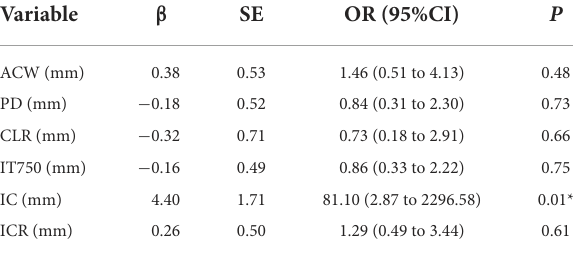
TABLE 3 Results of conditional logistic regression analysis assessing the risk factors related to excessively low vault ( < 100 µ m) ( n = 81).